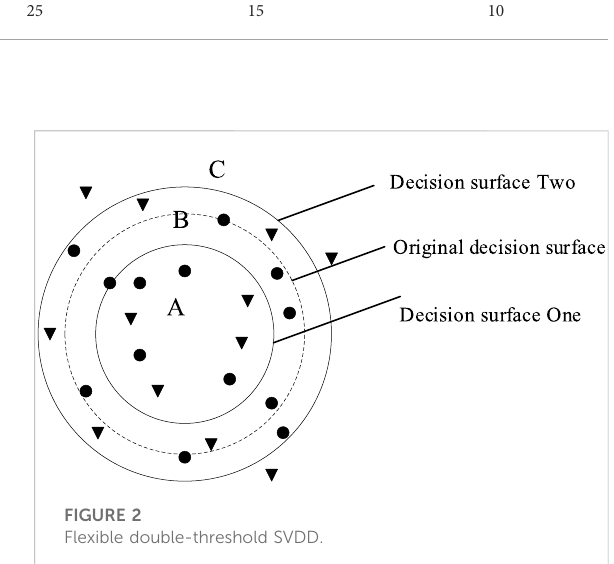
FIGURE 2 Flexible double-threshold